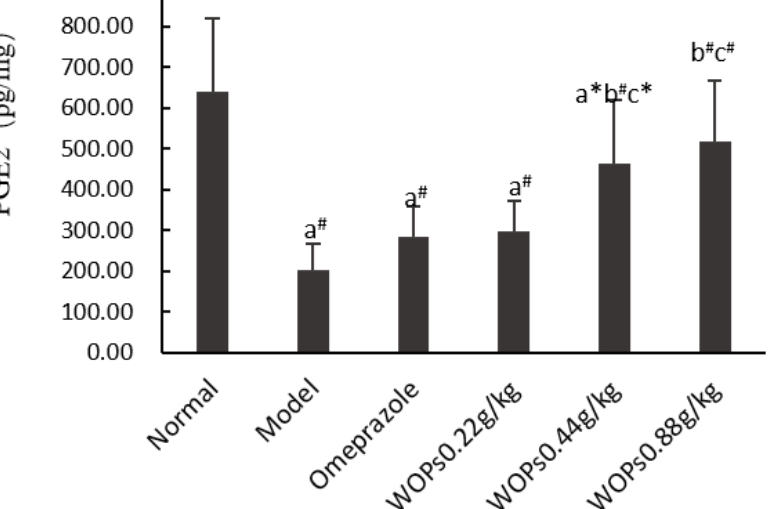
Figure 3. Effects of WOPs on PGE2 synthesis in gastric tissue of indomethacin-induced rats. Significance was represented as * p < 0.05, # p < 0.01; a represents comparison with the normal group, b refers to comparison with the model group, and c refers to comparison with the omeprazole group; 10 per group. PGE2—prostaglandin E2; WOPs—walnut oligopeptides.